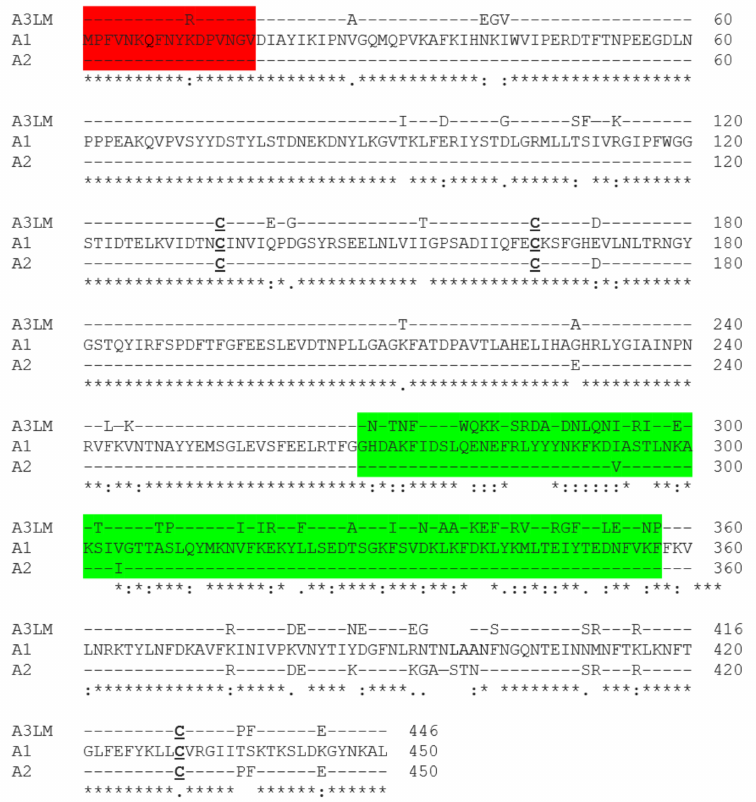
Figure 2. Blastp alignment of A3 versus A1. The primary amino acid sequences of A3LM (top) ACA57525, A1 (middle) ACS66881, and A2 (bottom) ADB85243 were analyzed by Blastp [32]. The bottom line depicts identical amino acids between A1, A2, and A3LM ( * ); conserved amino acids (:); and non-conserved amino acids ( ). Shown are the N region (amino acids 1–17, red) and the low homology domain (LHD, green), which comprises amino acids 268–357 and has ~60% identity between A3LM and A1. Cysteine residues are bolded and